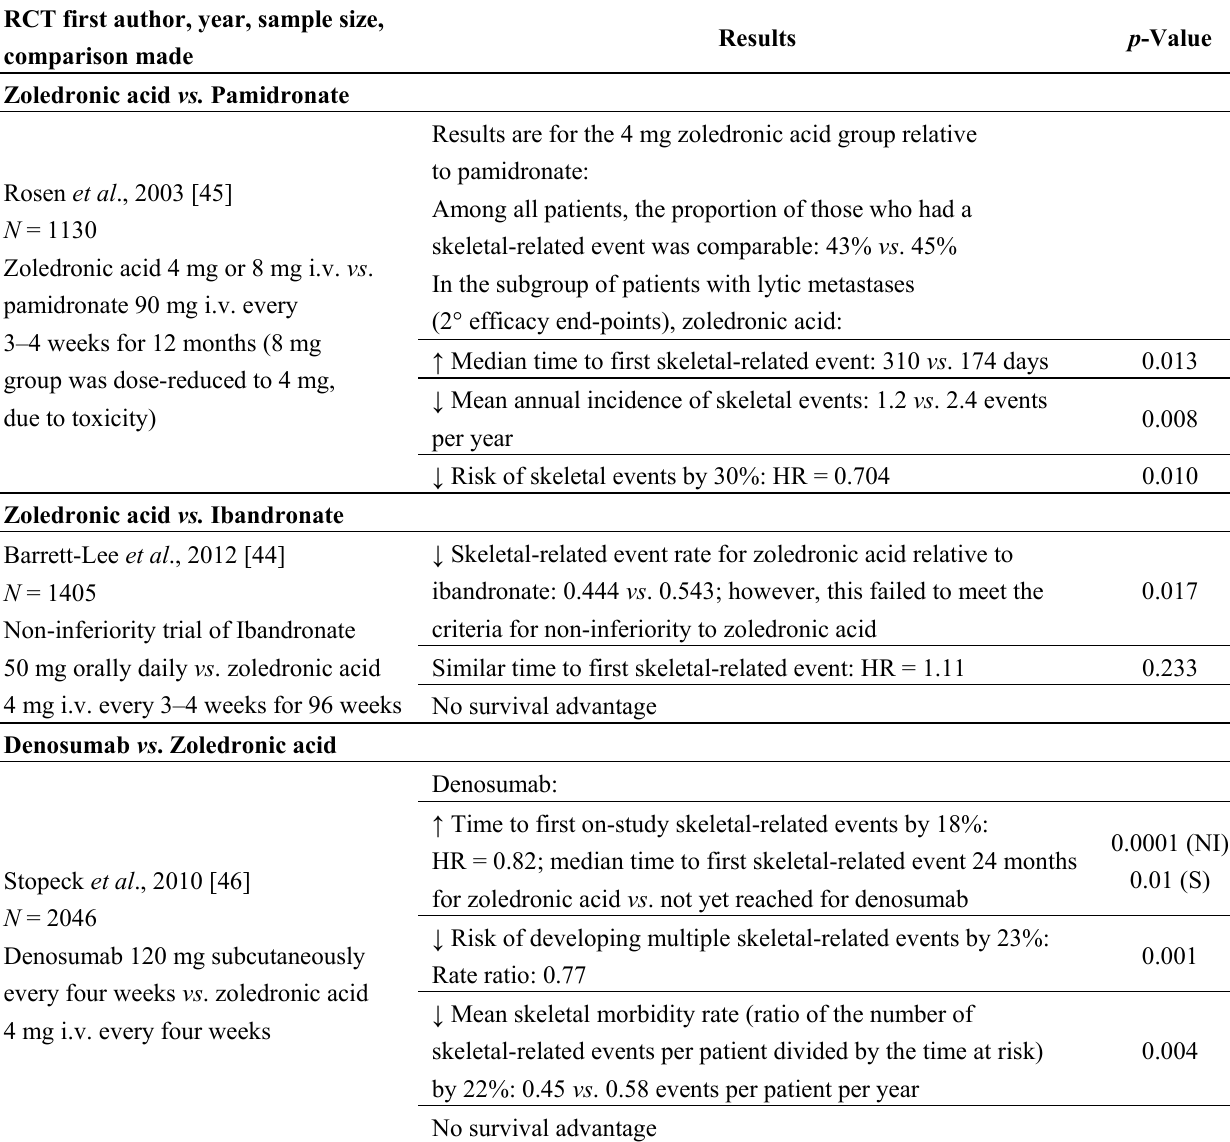
Table 2. Comparative trials of bone-modifying therapies available for clinical use. RCT first author, year, sample